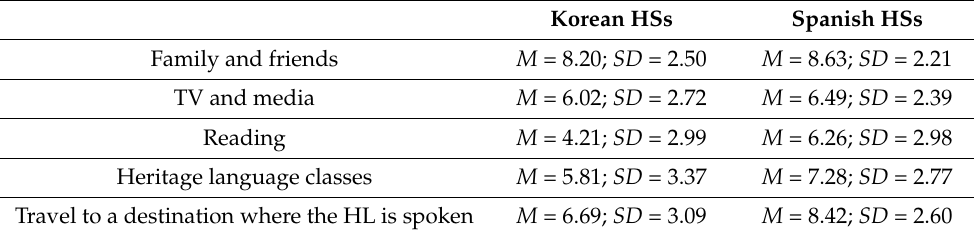
Table 6. Reported importance of factors contributing to HL maintenance across HS